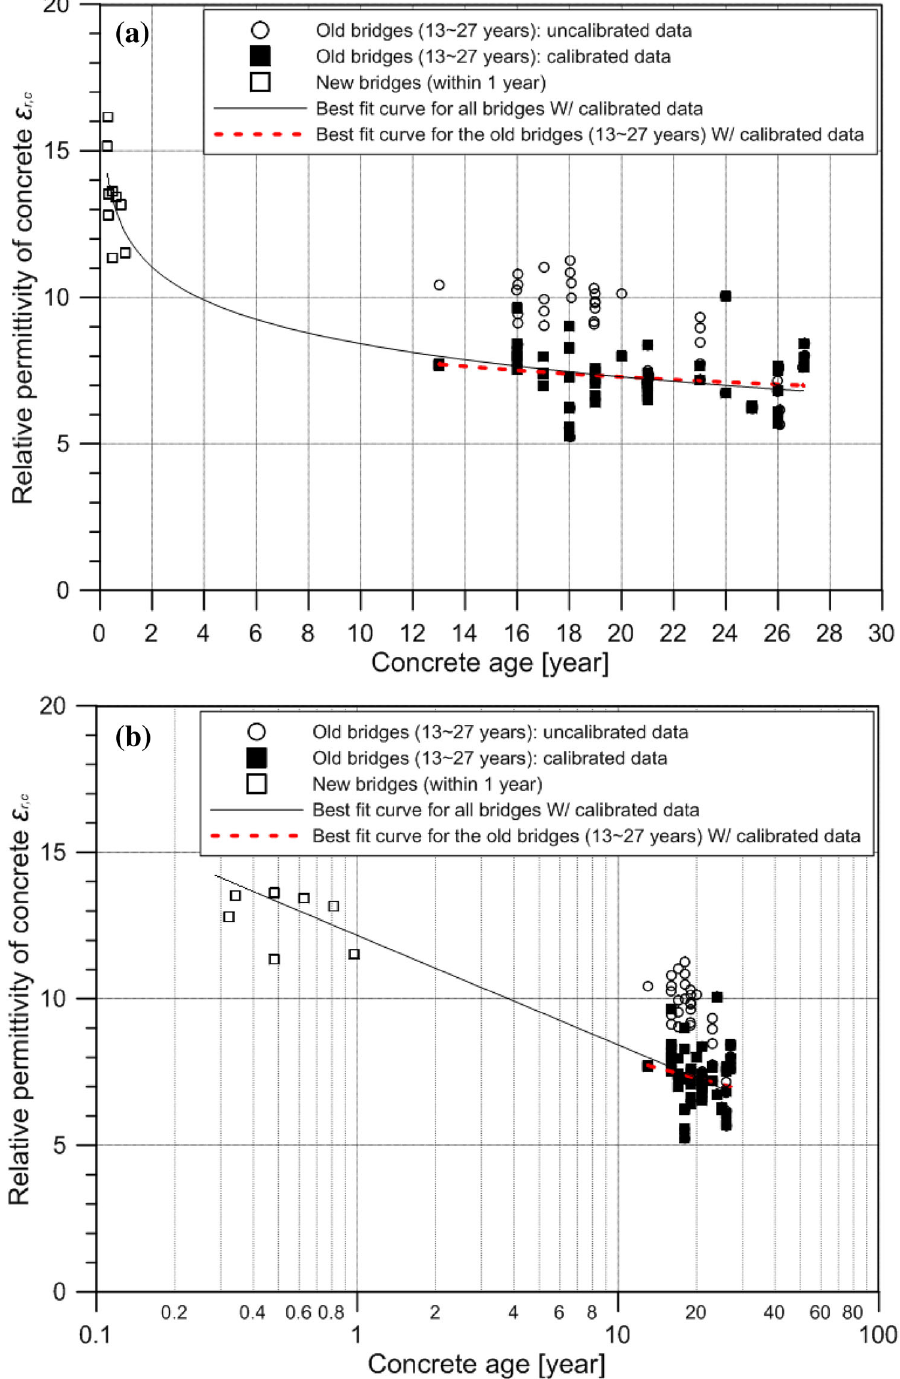
Fig. 10 Variation of calibrated relative permittivity of concrete in old bridges with concrete age: a linear- and b logarithmic scale in the horizontal axis for concrete age. For a comparison, data from new bridges and old bridges before calibration are shown in the same